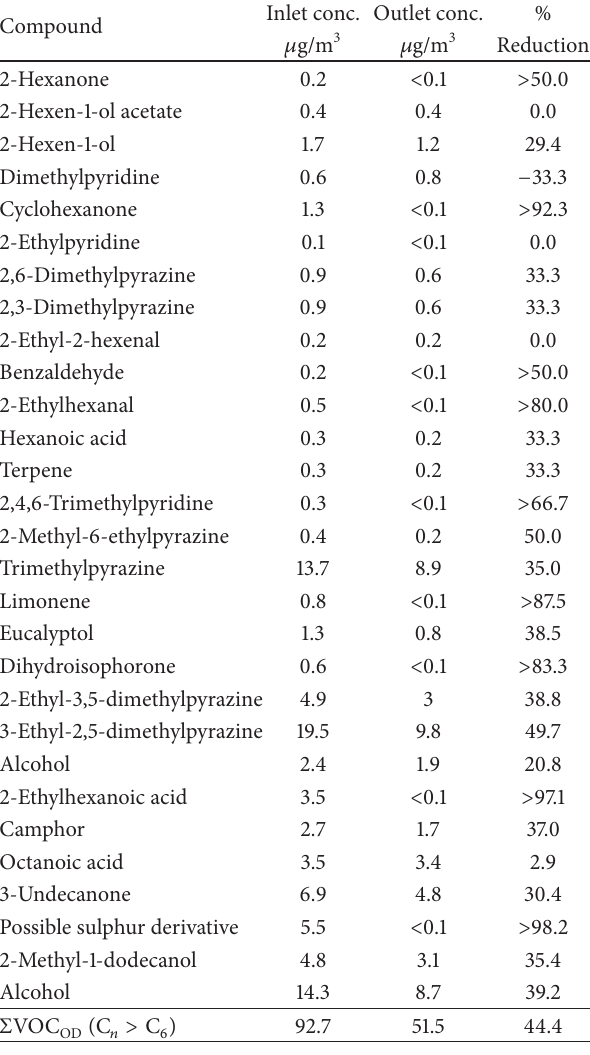
Table 4: Odoriferous VOC reduction, corresponding to Day